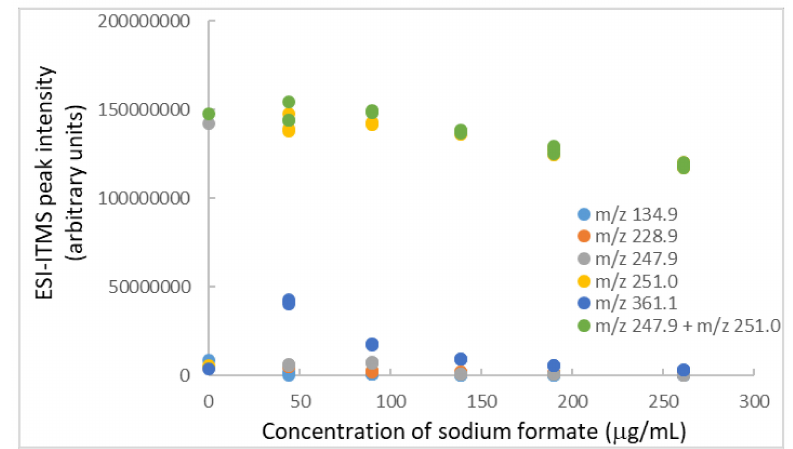
Figure 6. Impact of sodium formate on ESI-ITMS analysis of BPA solution (25 µ g / mL) containing TiO 2 nanoparticles (104 µ g / mL) and l -glutamic acid (41 µ g / mL). Relative standard deviation of each data point =